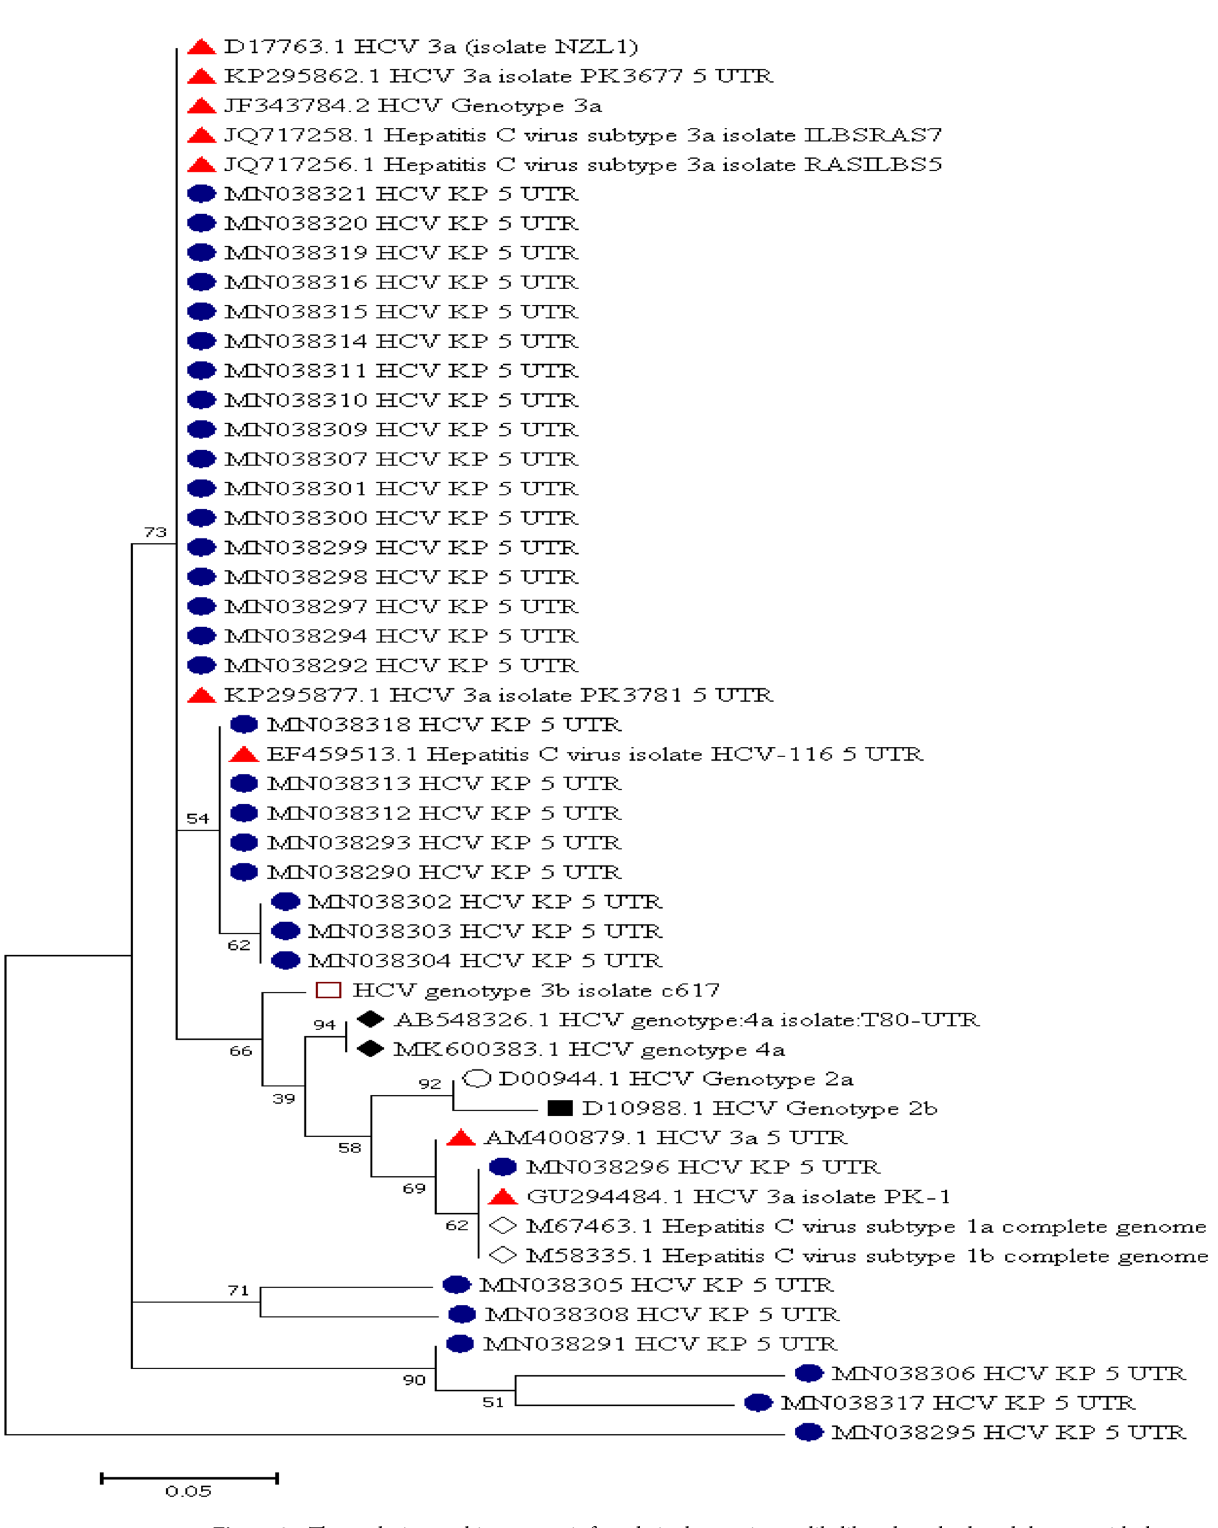
Figure 3. The evolutionary history was inferred via the maximum likelihood method, and the tree with the highest log likelihood (− 421.51) is displayed. The percentage of trees in which the linked taxa clustered together is presented next to the branches. All positions with absent data and gaps were removed. There were a total of 84 positions in the final dataset. Evolutionary analyses were performed by MEGA7 and HCV 5 ′ UTR sequences with reported genotypes. The highlighted samples show different genotypes, and genotype 3 (highlighted in red) was predominant and matched with the reference